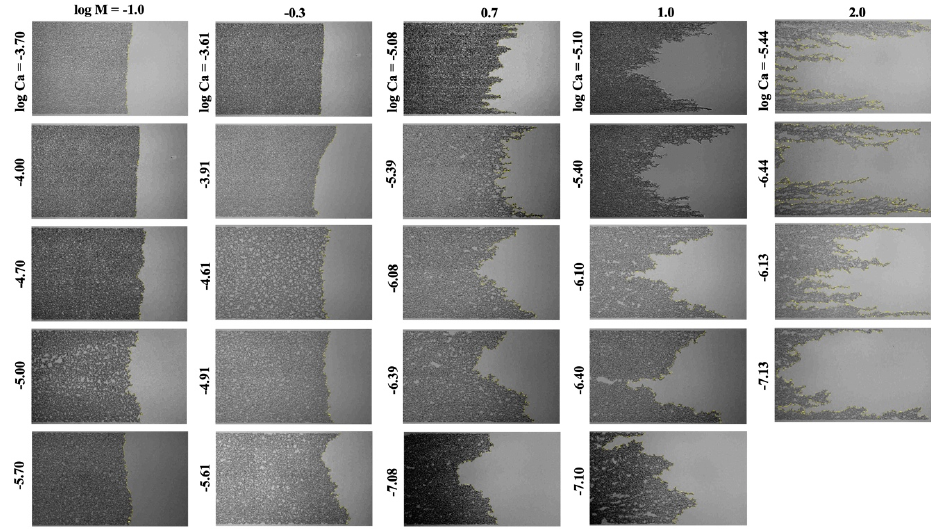
Figure 7. Image of displacement fronts in imbibition experiments.